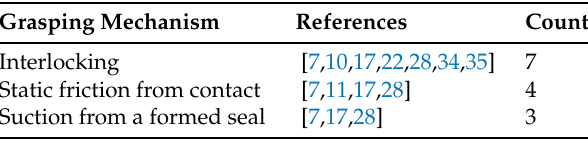
Table 14. Frequency of detailed grasp